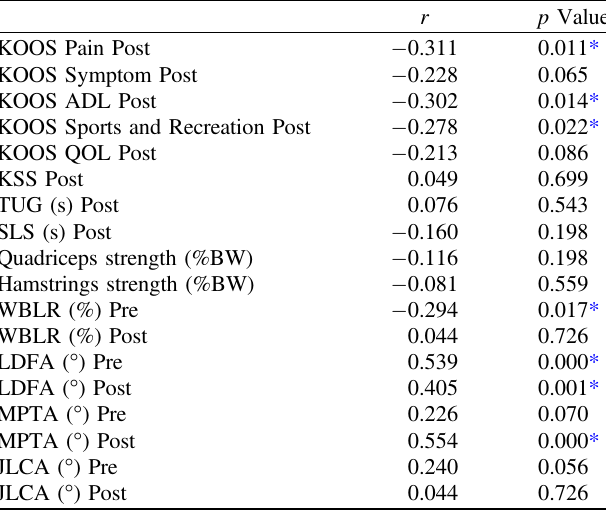
Table 2. Factors correlated with joint line obliquity after OWHTO.